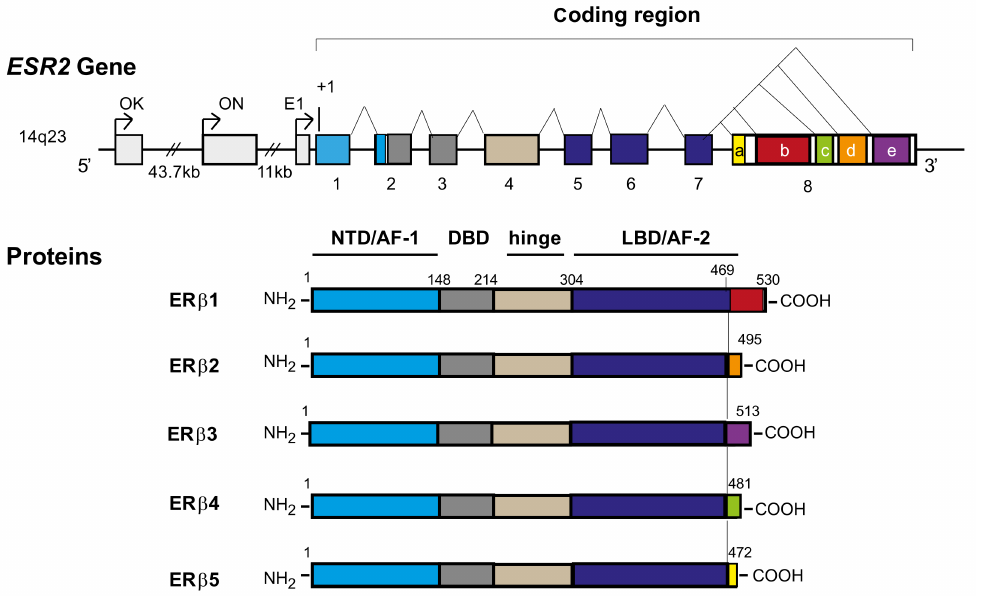
Figure 1. Schematic representation of ESR2 gene and human ER β protein isoforms (ER β 1–5). Within the 5 (cid:48) untranslated region of ESR2 , three distinct promoters are found (OK, ON, and E1). Exons 1–8 are represented by boxes, and the introns are represented by lines. Exons are represented in different colors, and their encoding protein domains are represented by the corresponding colors. The use of alternative acceptor sites leads to the production of five different proteins (ER β 1, ER β 2, ER β 3, ER β 4, and ER β 5). All these isoforms share common exons 1–7 but differ in their alternative exon 8 (b, d, e, c, and a respectively). For protein isoforms, from the N-terminus to C-terminus, the N-terminal domain (NTD)/activation function 1 (AF-1) is colored in blue, the DNA binding domain (DBD) is colored in dark gray, the hinge domain is colored in clear brown, and the ligand-binding domain (LBD)/activation function 2 (AF-2) is colored in dark blue. At the end of the protein, the alternative splicing produces proteins identical in their first 468 amino acids but differing in the sequence corresponding to the end of the ligand binding of ER β 1, which modifies their capacity to bind ligands. Numbers indicate the amino acids of the